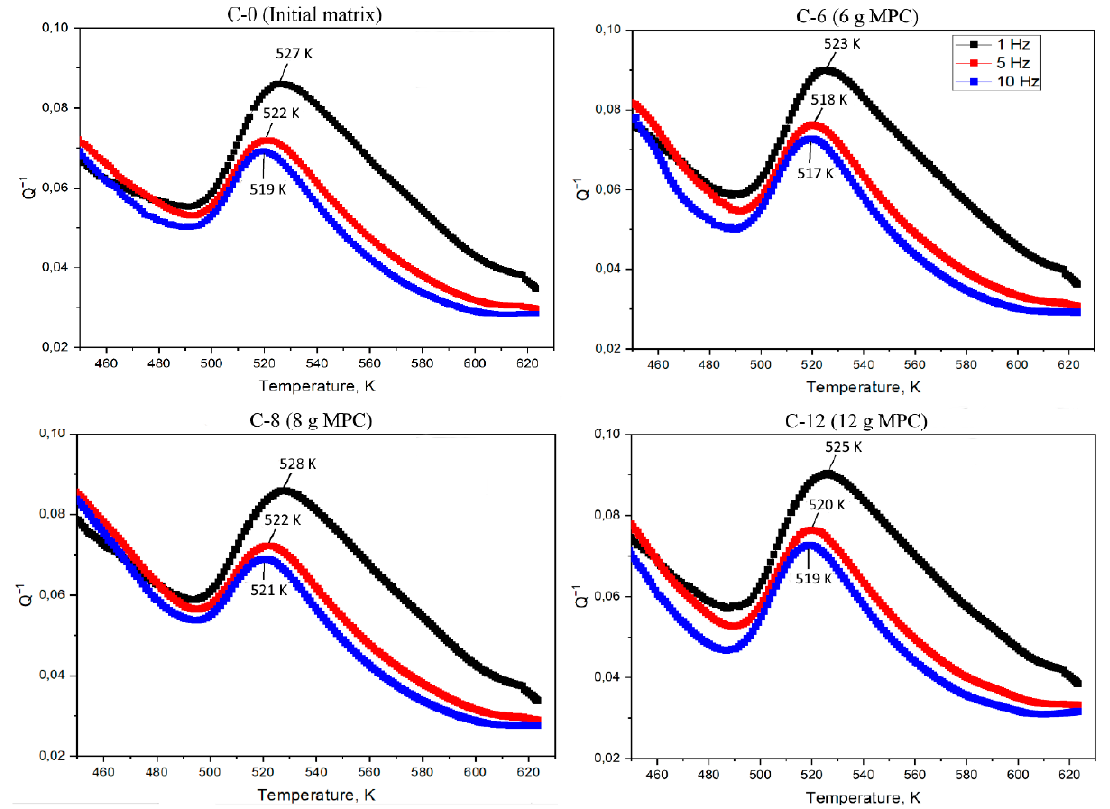
Figure 4. Dependence of internal friction on temperature Q − 1 (T) obtained at frequencies (1, 5, and 10 Hz) for various filled composites.